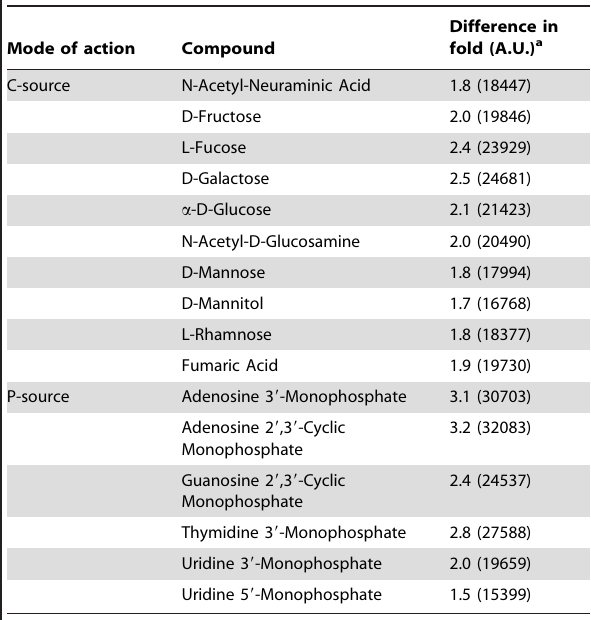
Table 2. Changes in carbon, and phosphate source utilization greater than or equal to 1.5-fold due to ramA inactivation comparing S . Typhimurium LTL ramA::aph to its parental strain S . Typhimurium